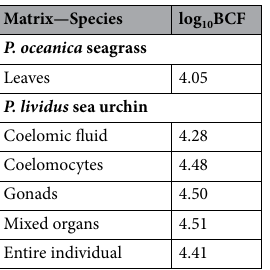
Table 1. Bioconcentration factors (BCF) calculated for each analyzed matrix collected from Site B